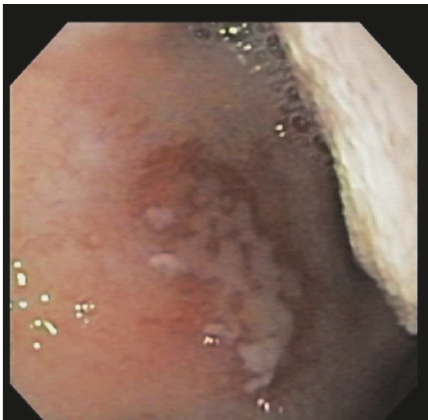
Figure 1: Blister on palate.